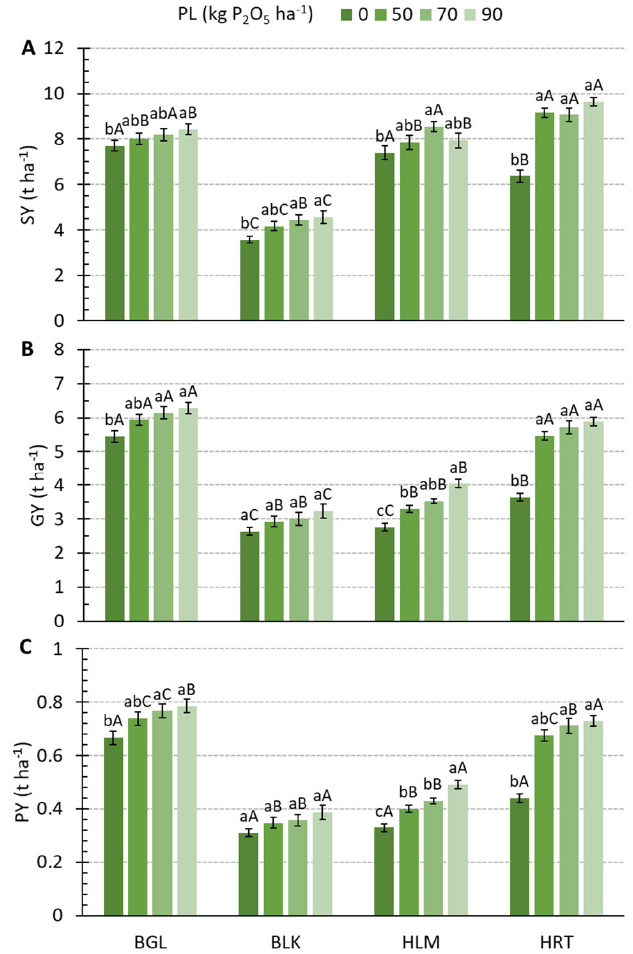
Figure 3. From top to bottom, the effect of phosphorous fertilization level (PL) at the four locations (BGL: Baghlan; BLK: Balkh; HLM: Helmand; HRT: Herat) on ( A ) the straw yield (SY), ( B ) grain yield (GY) and ( C ) protein yield (PY). Lowercase letters represent significant differences between PL levels within the same locations, and uppercase letters represent significant differences between locations within the same PL level according to the Tukey HSD post hoc test results.